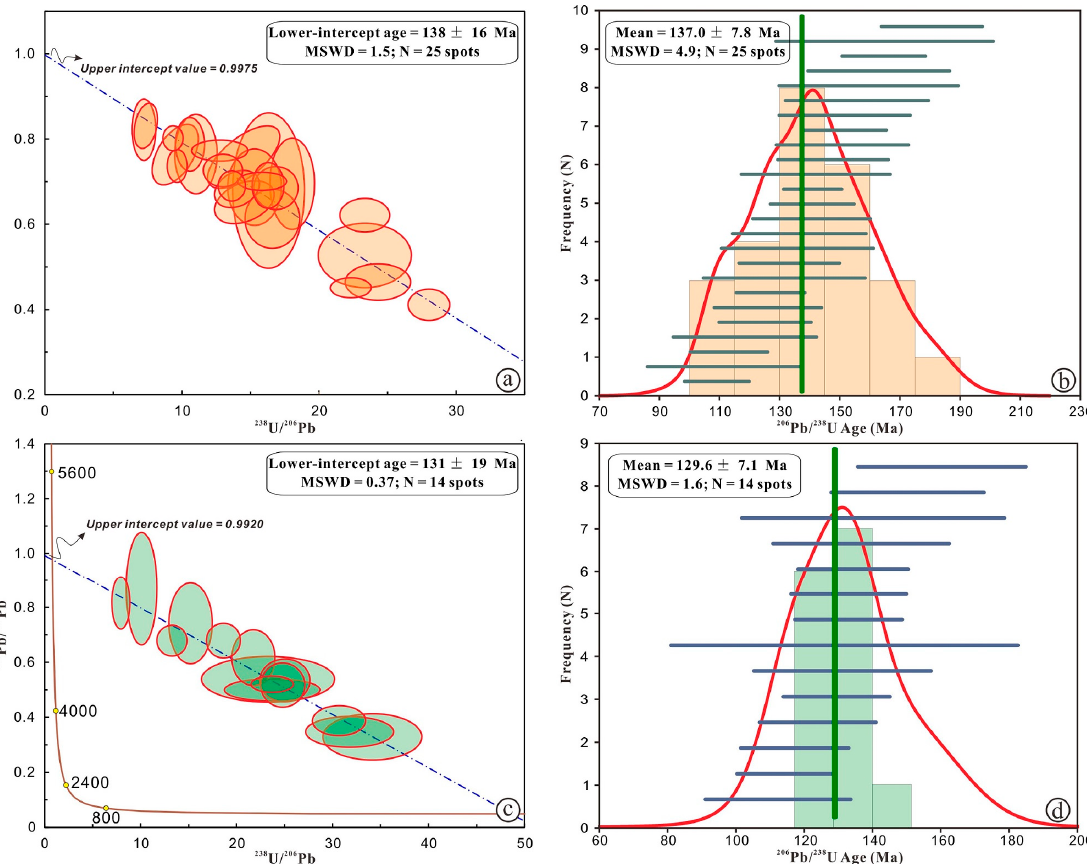
Figure 6. ( a ) Tera–Wasserburg diagram and ( b ) weighted average diagram of 207 Pb-corrected 206 Pb/ 238 U age for Grt1; ( c ) Tera–Wasserburg diagram and ( d ) weighted average diagram of 207 Pb-corrected 206 Pb/ 238 U age for Grt2.